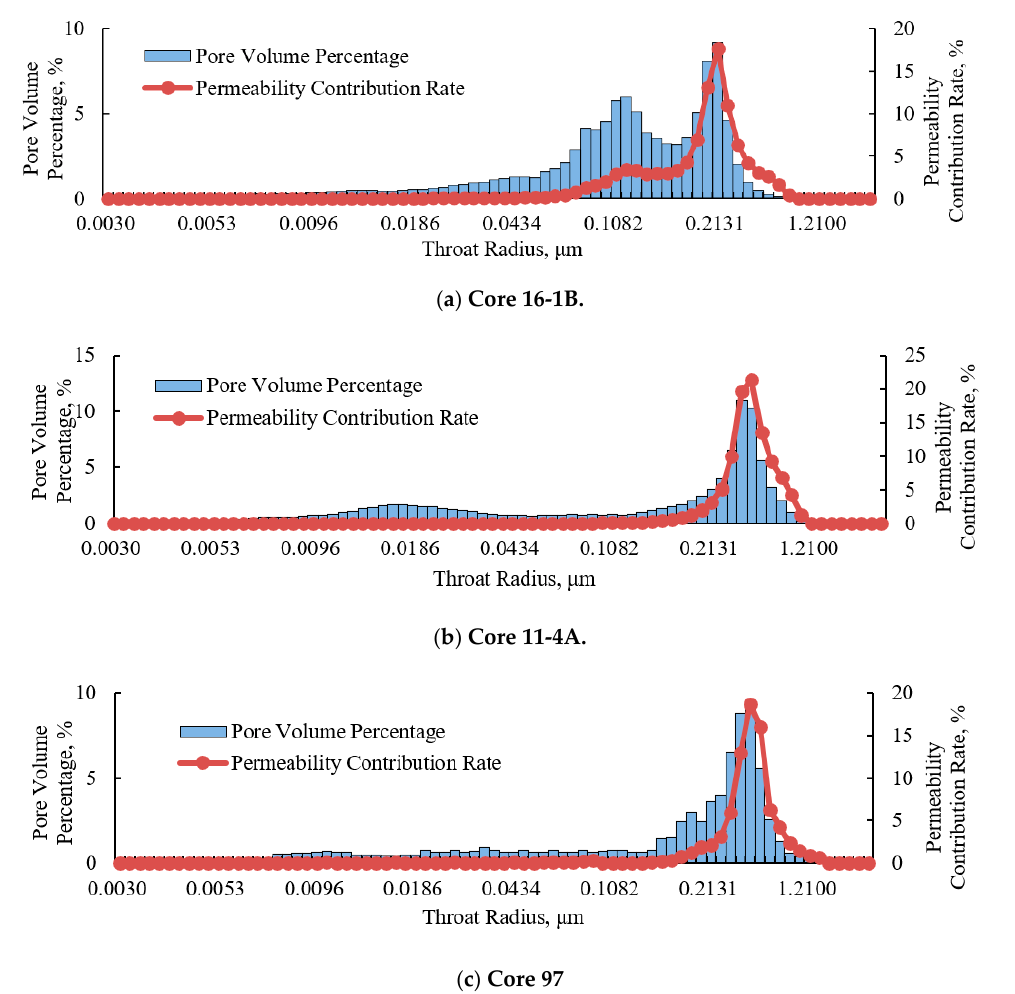
Figure 5. Pore throat distribution frequencies and permeability contributions of the three cores.